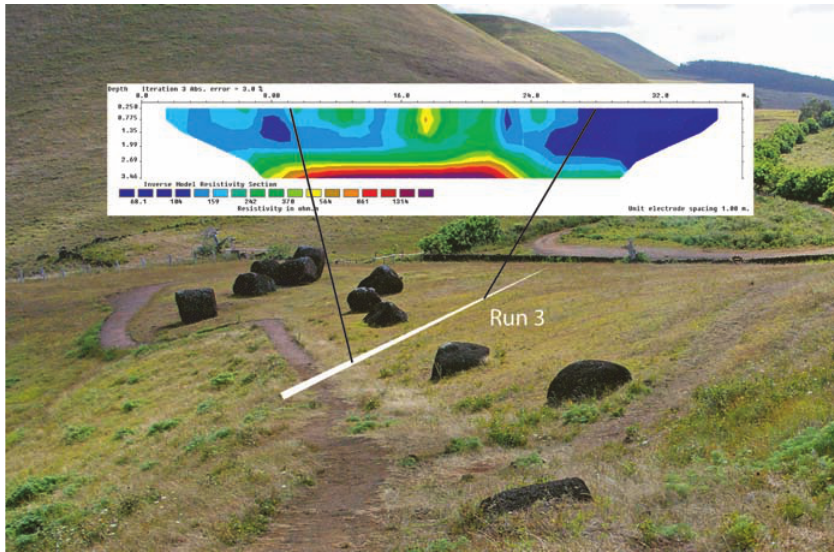
Figure 6 Tomography resistivity survey at Puna Pau. Nine, 40-metre long tomography runs were undertaken at intervals across the route of the suspected quarry ‘road’ down the outer slope of Puna Pau (located in the Figure to the right of the present day visitor path). The results are represented diagramatically as a slice of the underlying stratigraphy along the line of each run. Here red indicates high resistance to the passage of an electric current (the road on bedrock?), and blue represents low resistance (uncosolidated quarry debris?). In this representation of Run 3, bedrock - the quarry road, is 2.5m below the ground surface and covered in what is interpreted as later quarry